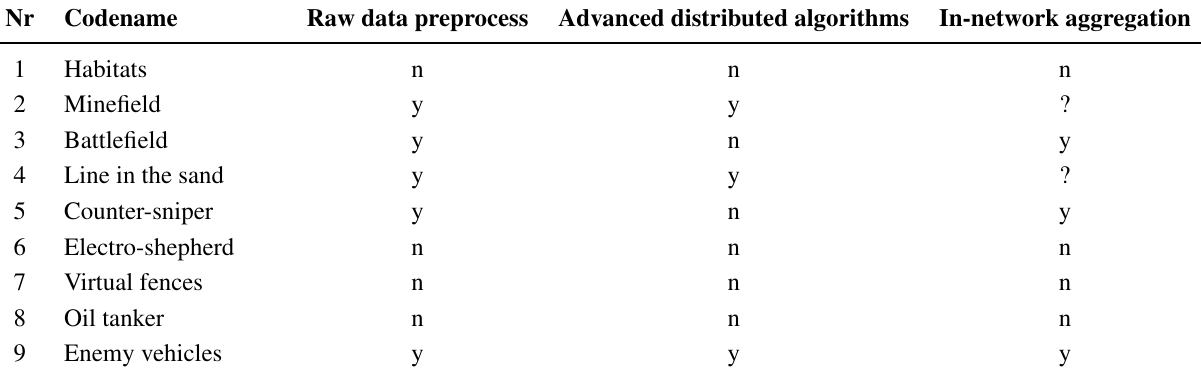
Table 11. Deployments: in-network